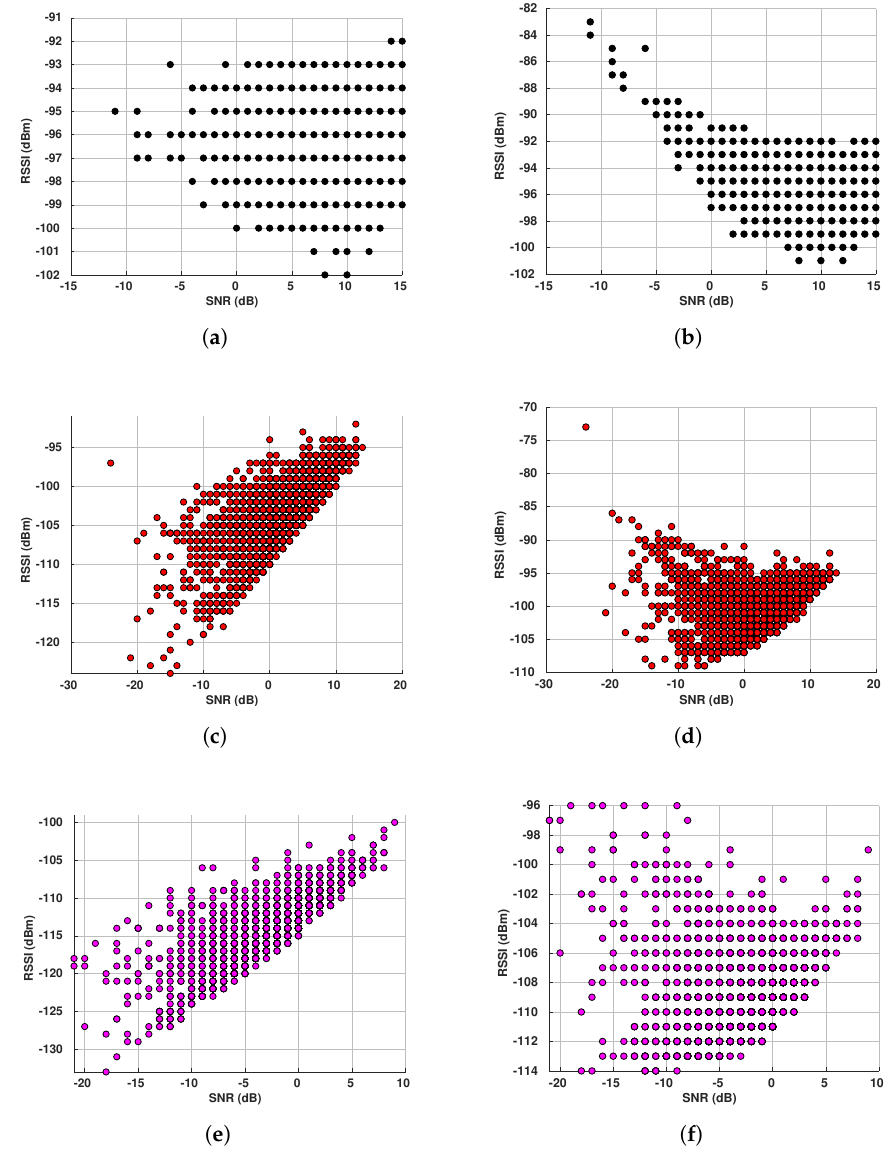
Figure 14. E5 RSSI x SNR for GW1 during different periods: I1 (16/01/2019 to 07/02/2019): − 16.96 ◦ C on average; I4 (30/09/2018 to 14/10/2018): 6.56 ◦ C on average; I5 (15/05/2019 to 22/05/2019): 13.22 ◦ C on average. ( a ) RSSI Signal—I1. ( b ) RSSI Channel—I1. ( c ) RSSI Signal—I4. ( d ) RSSI Channel—I4. ( e ) RSSI Signal—I5. ( f ) RSSI